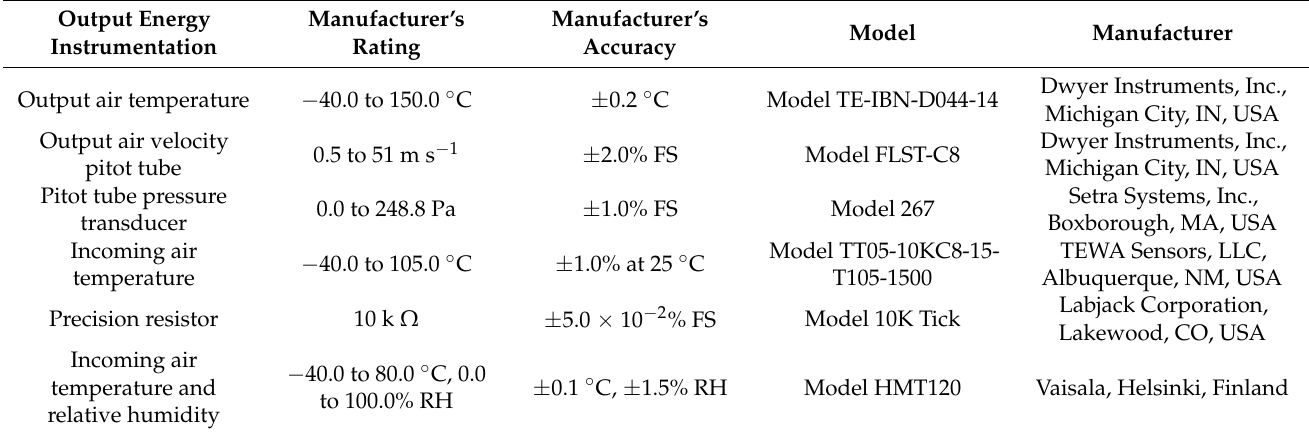
Table 3. Energy output instruments used in the study in order as described in the